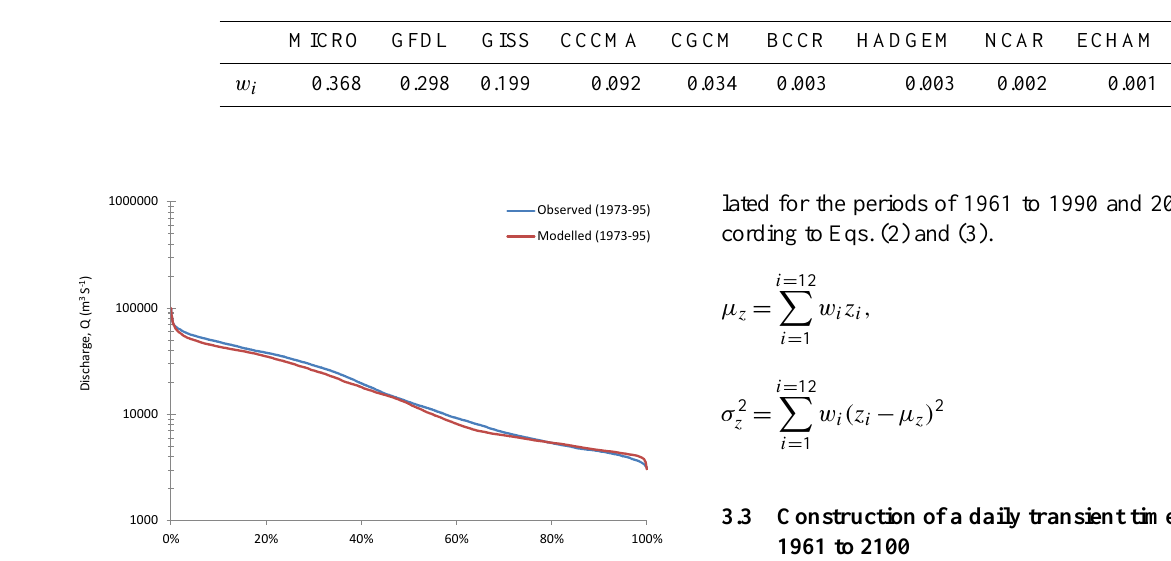
Table 1. Computed weighing factors for the different model forcings.